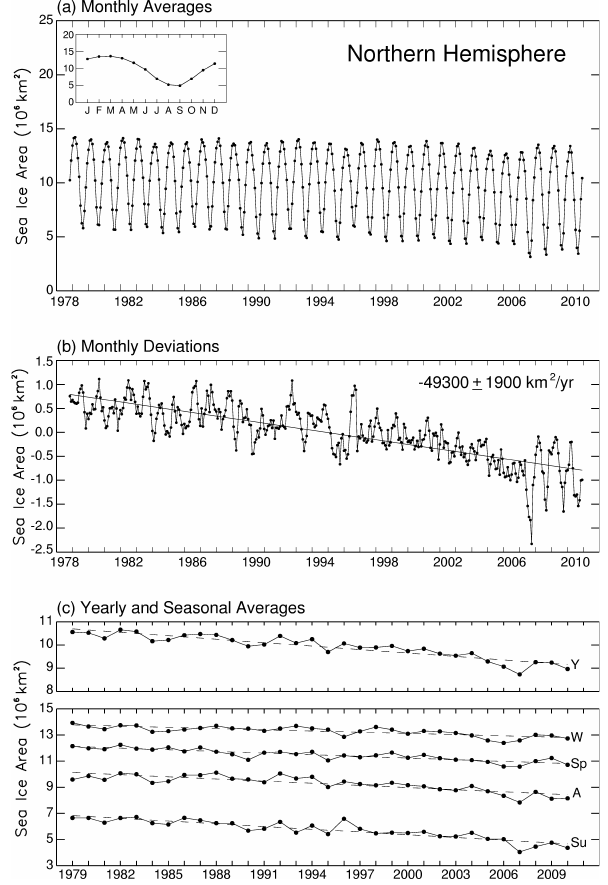
Fig. 5. (a) Monthly averaged Northern Hemisphere sea ice areas for November 1978 through December 2010. The inset shows the average annual cycle. (b) Monthly deviations for the sea ice ar- eas. (c) Yearly and seasonally averaged sea ice areas for the years 1979–2010. The winter (W), spring (Sp), summer (Su), and